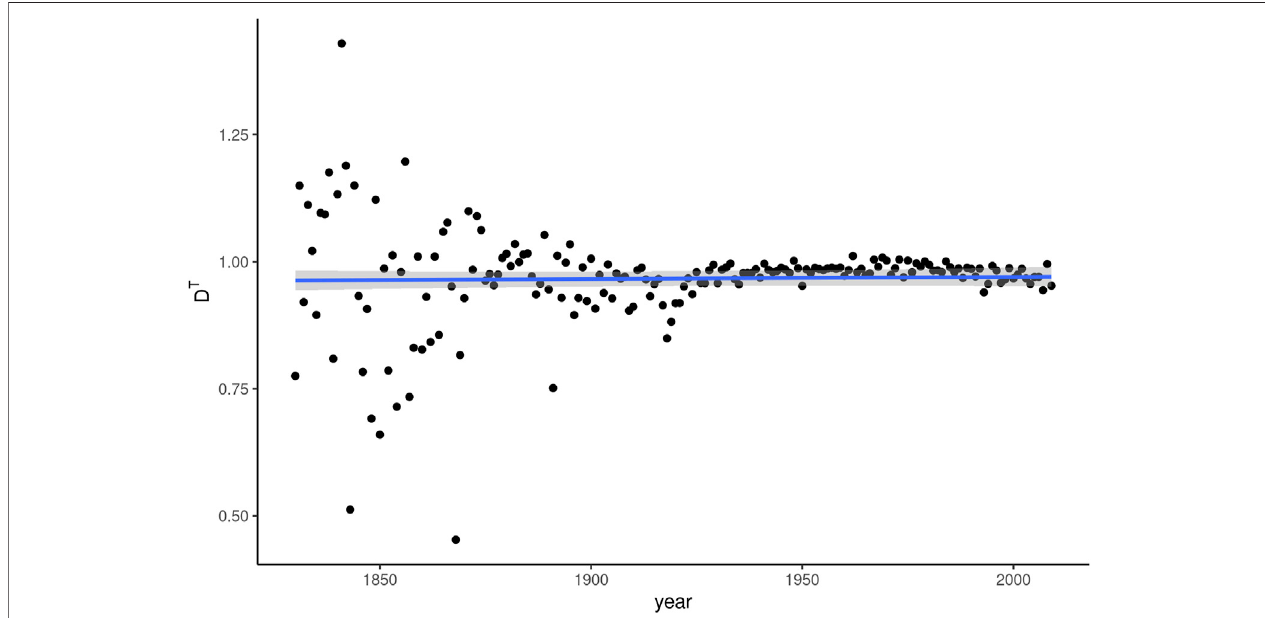
FIGURE 6 | Topic dissemination (D T ) of whom over 180 years of written American